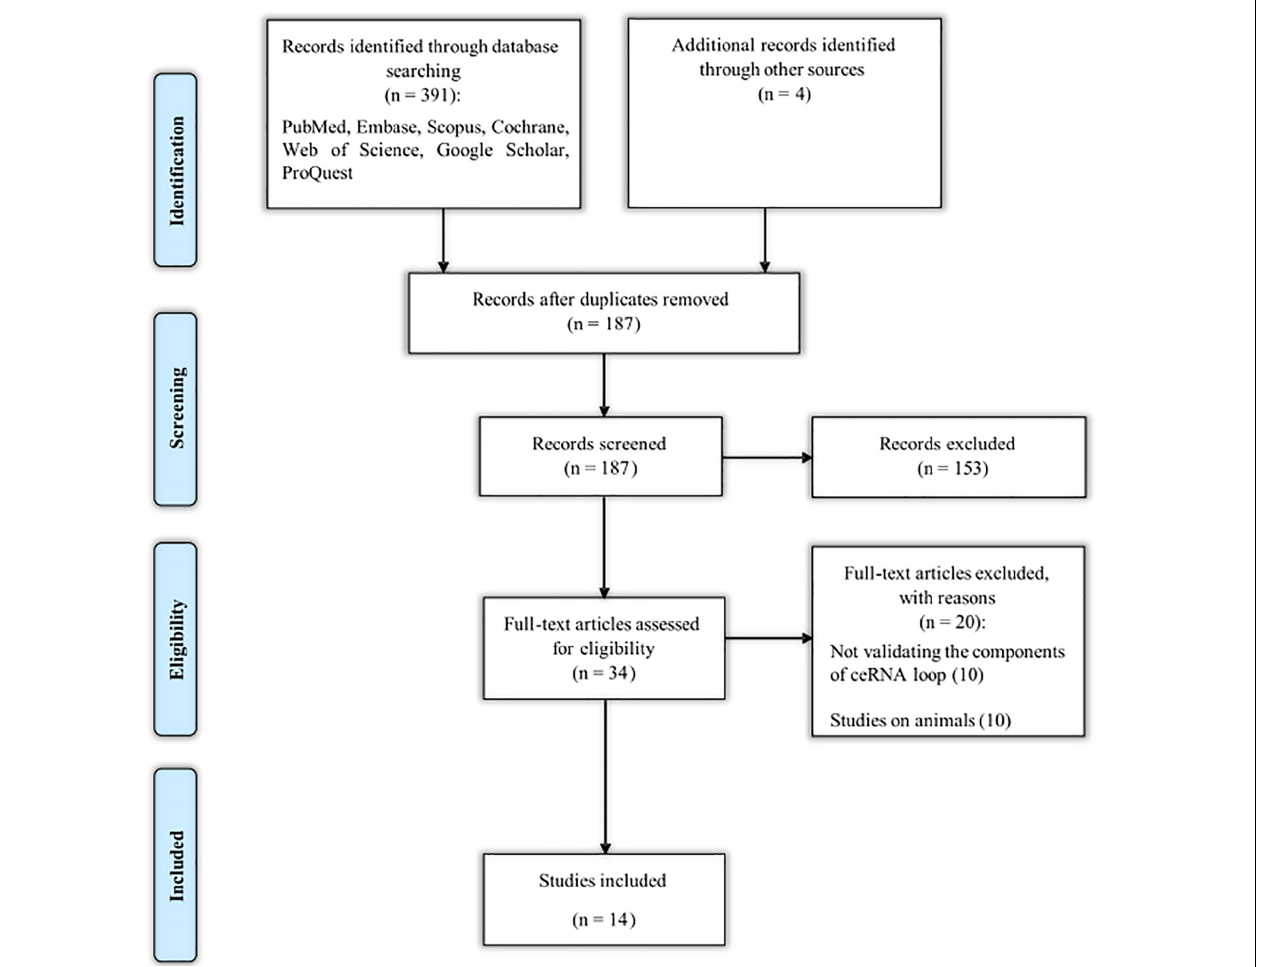
FIGURE 2 | Search strategy flow chart based on the PRISMA flow